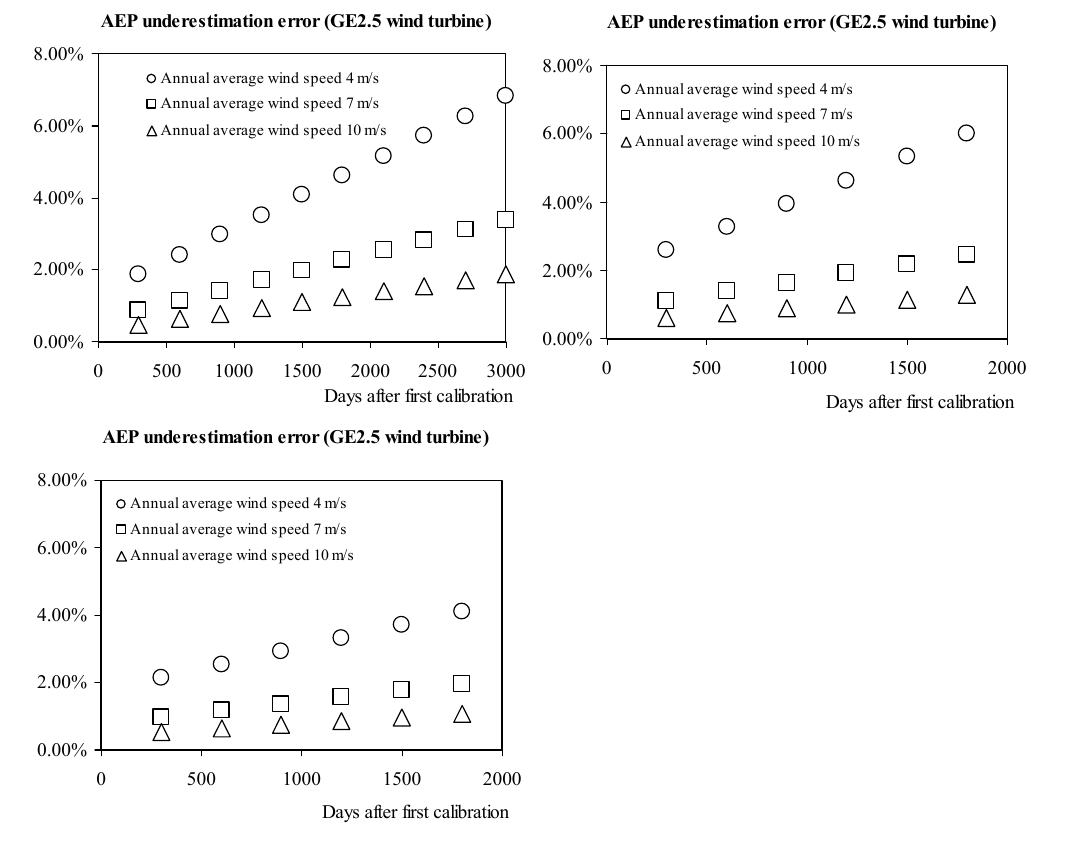
Figure 5. Underestimation of the measured wind speed, Δ V , as a function of the reference wind speed for the three anemometers considered (left: Cl-100075; middle: A100 L2; right: Th-4.3350) 300, 900 and 1,800 days after the first calibration of the anemometer. Confidence level: